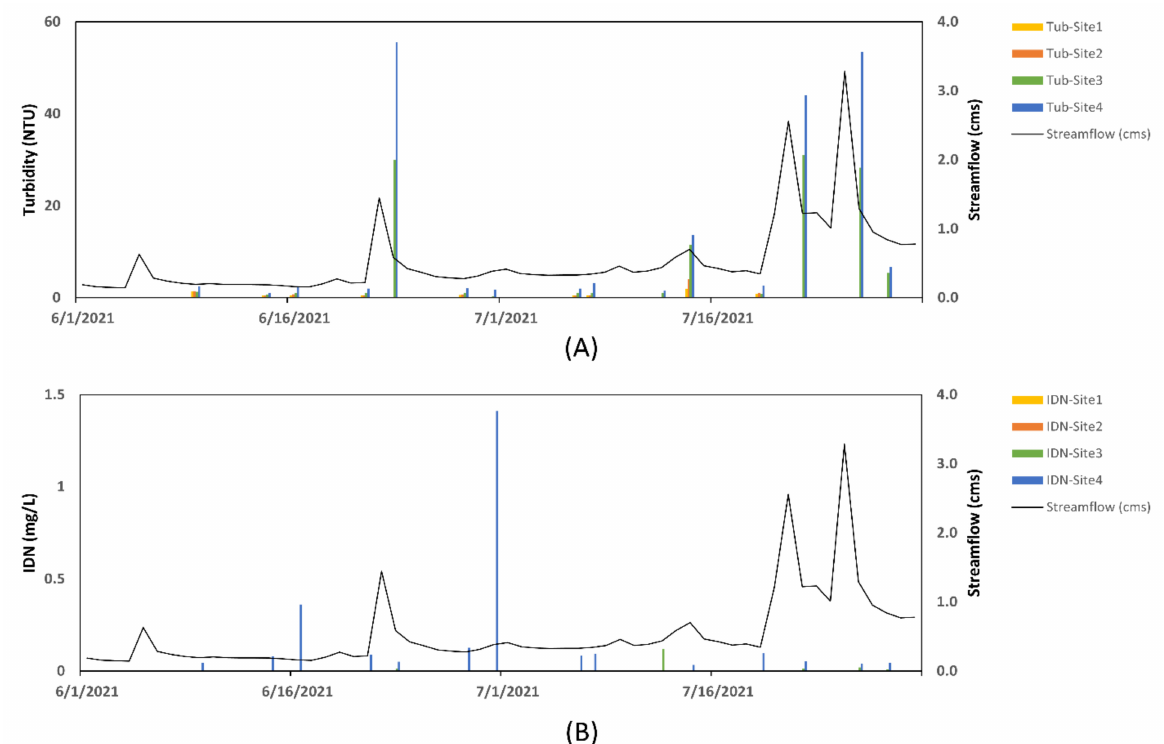
Figure 7. Observed streamflow at Site 3, and turbidity and IDN data at four sites for the project period (1 June–4 August). ( A ) turbidity values at four sites, ( B ) IDN values at four